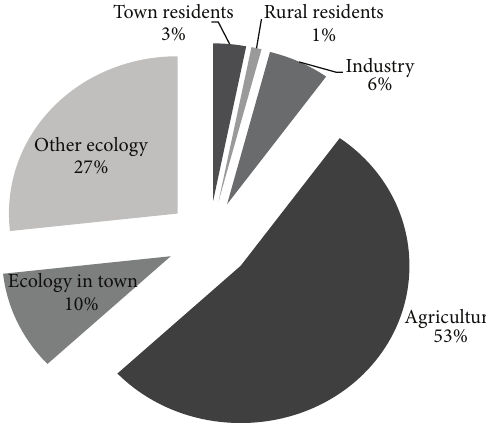
Figure 15: Analysis of integrated ET in